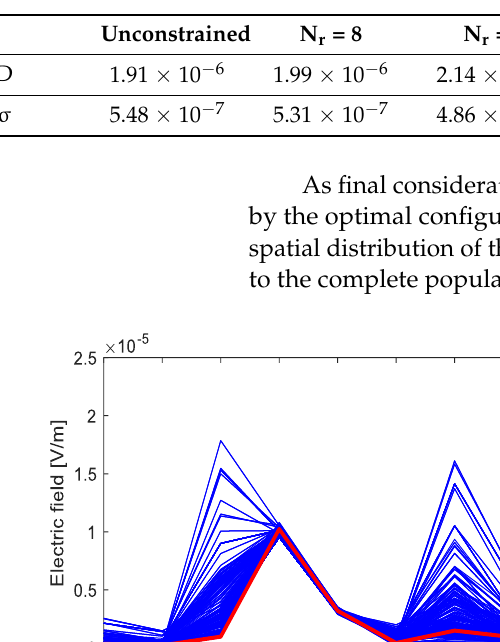
Table 4. Statistical properties of optimal Pareto fronts in Figure 11.